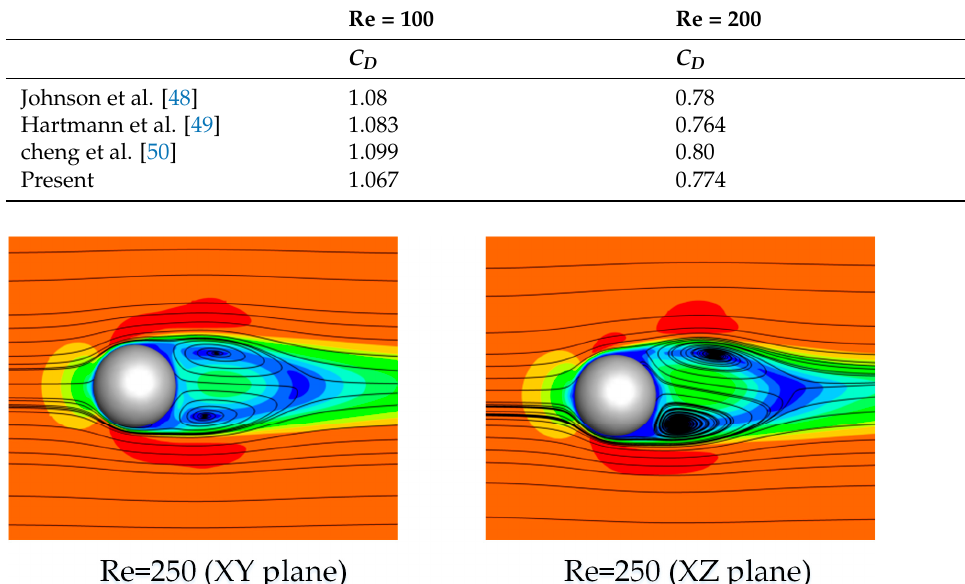
Figure 24. Streamlines and velocity contours for flow past a sphere at Re = 250.